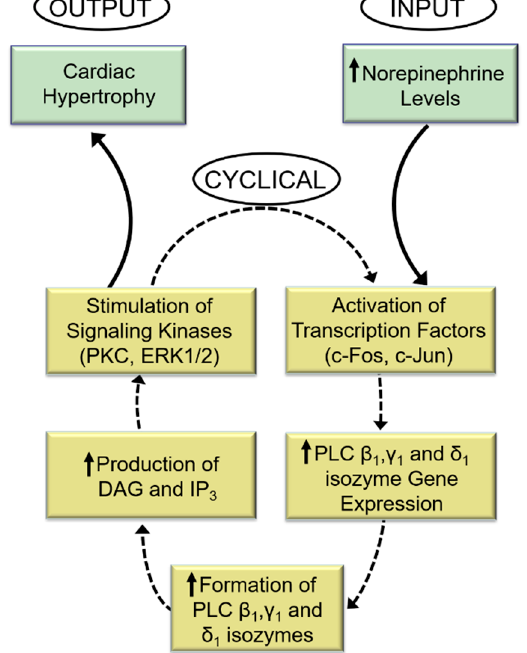
Figure 2. Role of phospholipase C in the perpetuation of cardiomyocyte growth response to norepi- nephrine. DAG = sn -1,2-diacylglycerol; IP 3 , inositol-1,4,5-trisphosphate. The response to increased levels of norepinephrine (input) is a cyclical process that produces an increase in the expression of PLC isozyme genes and subsequent higher generation of DAG and IP 3 and stimulation of the signal for cardiac hypertrophy (output). The activation and amplification of PLC isozymes ensure contin- uation of this cycle of events for continuation of abnormal hypertrophic growth due sustained ex- posure to high levels of norepinephrine.